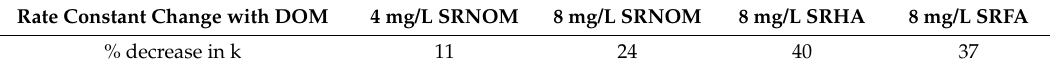
Table 2. Percent decrease in carbamazepine (CBZ) degradation rate constant (k) in the presence